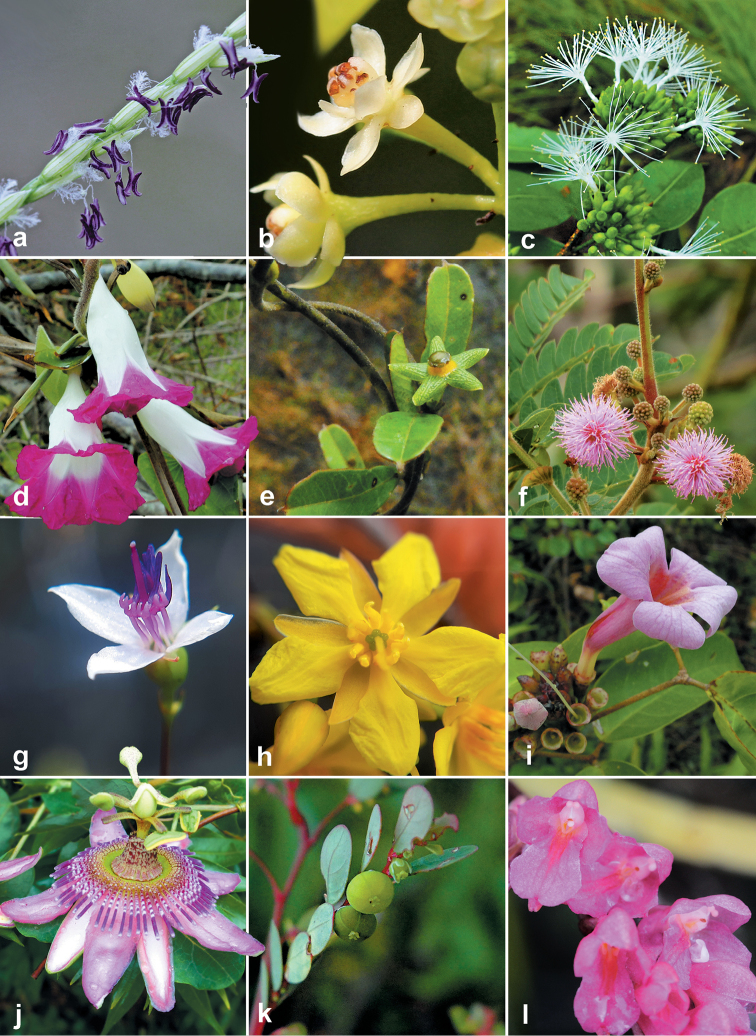
Representative species of canga in new dataset, SFXaAxonopus
longispicus (Döll) Kuhlm bDicypellium
aff.
caryophyllaceum (Mart.) Nees cInga
heterophylla Willd dIpomoea
decora Meisn eMatelea
microphylla Morillo fMimosa
dasilvae A.S.L. Silva & Secco gNepsera
aquatica (Aubl.) Naudin hOuratea
cearensis (Tiegh.) Sastre & Offroy iPachyptera
incarnata (Aubl.) Francisco & L.G. Lohmann jPassifora
picturata Ker Gawl. kPhyllanthus
minutulus Mull.Arg. lRodriguezia
lanceolata Ruiz & Pav.